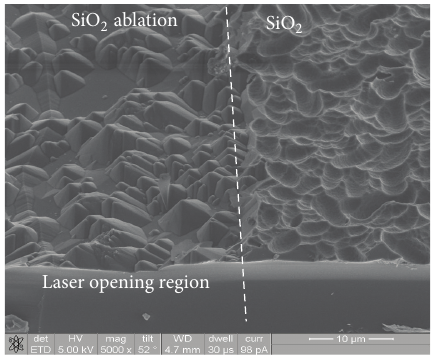
Figure 2: SEM image of the mc-Si substrate after laser opening with the fluence of 2 J/cm 2 , in which the laser-irradiation duration is 10ns